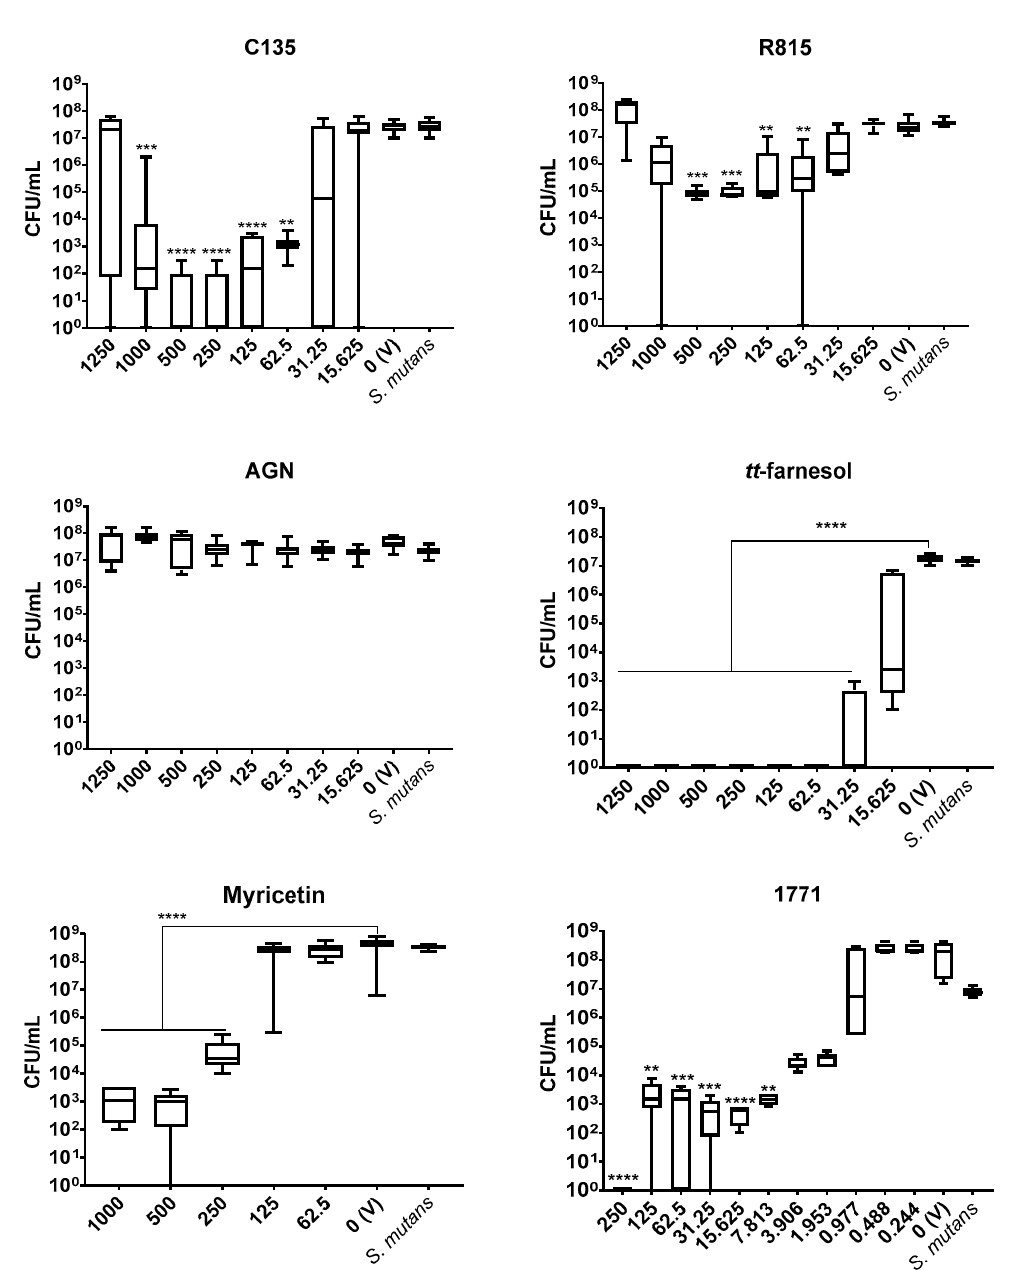
Figure 1. Antimicrobial activity of S. mutans using six compounds: C135, R815, AGN, tt -farnesol, myricetin and 1771. Data represents median and interquartile ranges ( n = 9). Statistical differences are represented with ** ( p < 0.05), *** ( p < 0.001), and **** ( p < 0.0001) (Kruskal Wallis, followed by Dunn’s test). The tabulated results are in Table S1.